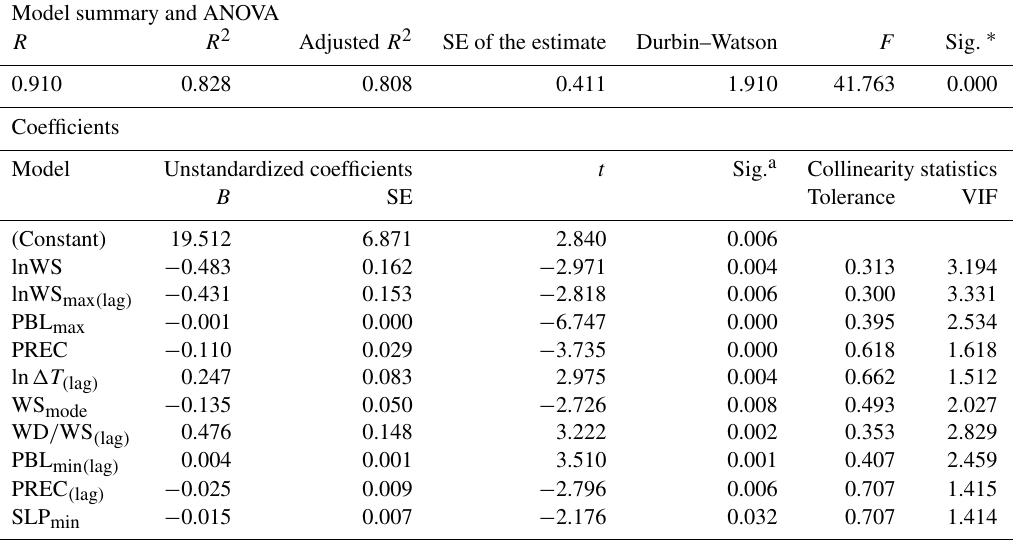
Table 7. The output indexes of the PM 2 . 5 GLM, including a model summary, analysis of variance (ANOVA), coefficients, and other indexes. Model summary and ANOVA